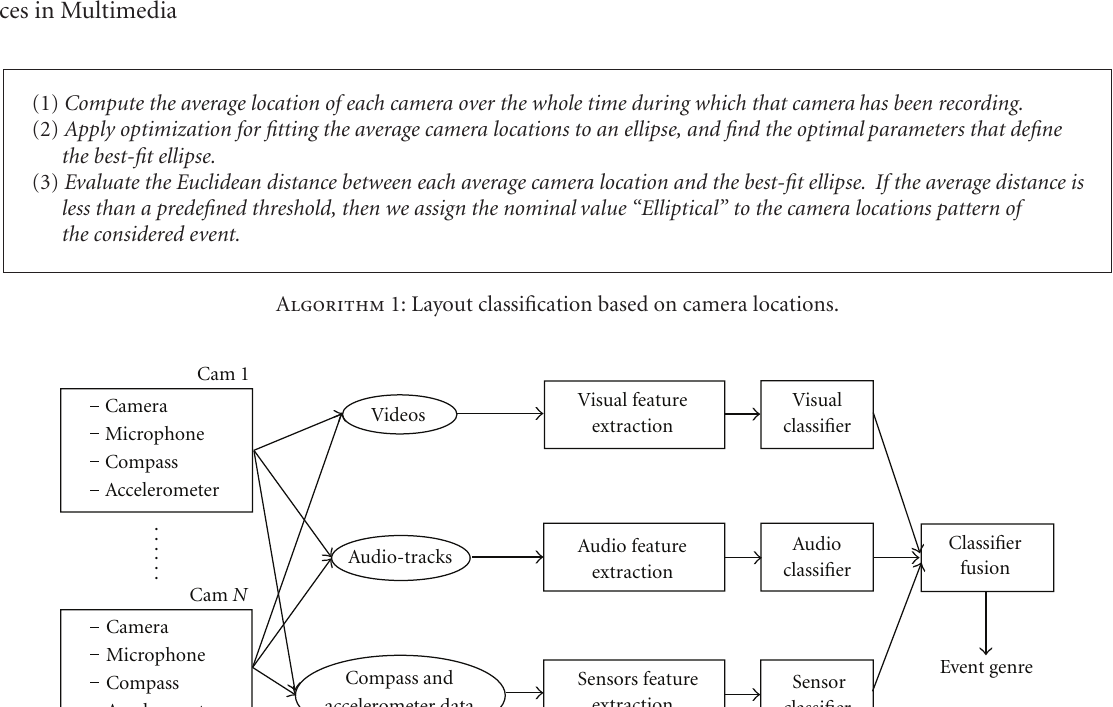
Figure 6: Processing steps for classifying the event